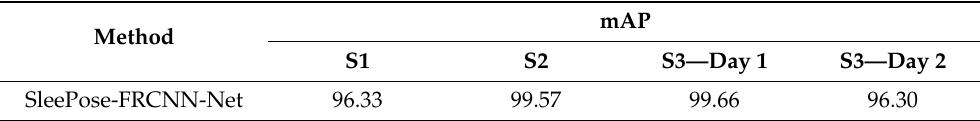
Table 13. Results of detection on the YouTube dataset.